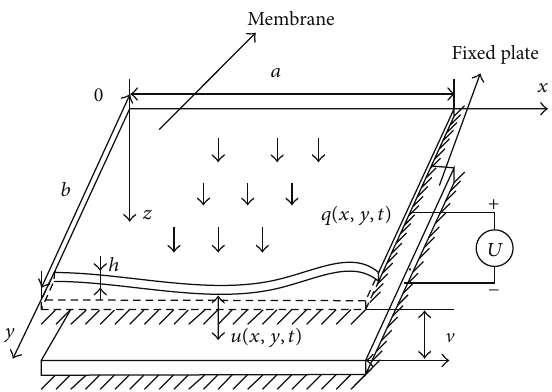
Figure 1: Multifields coupled dynamic model of a micro